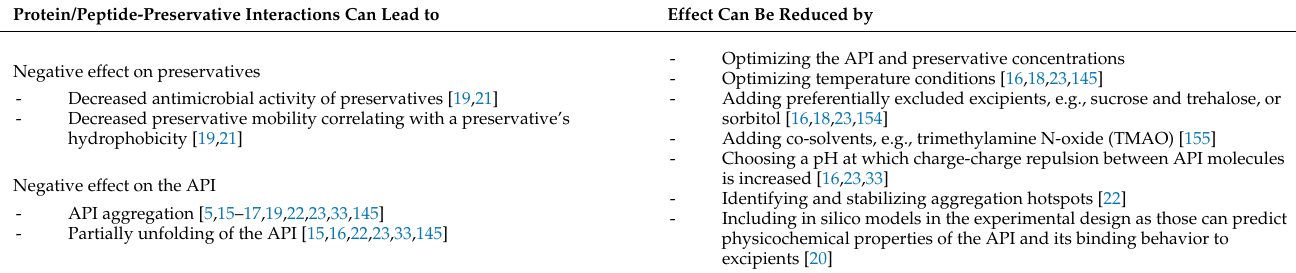
Table 13. General overview of possible protein/peptide-preservative interactions and their effects. Additionally, it is shown how these effects can be